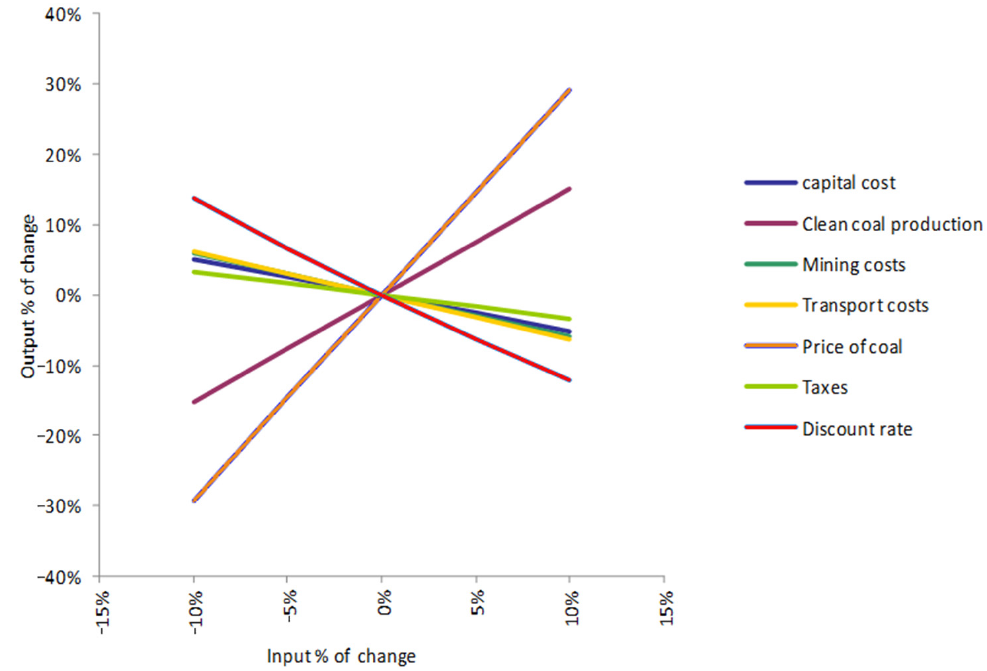
Figure 3. Spider graph of NPV.